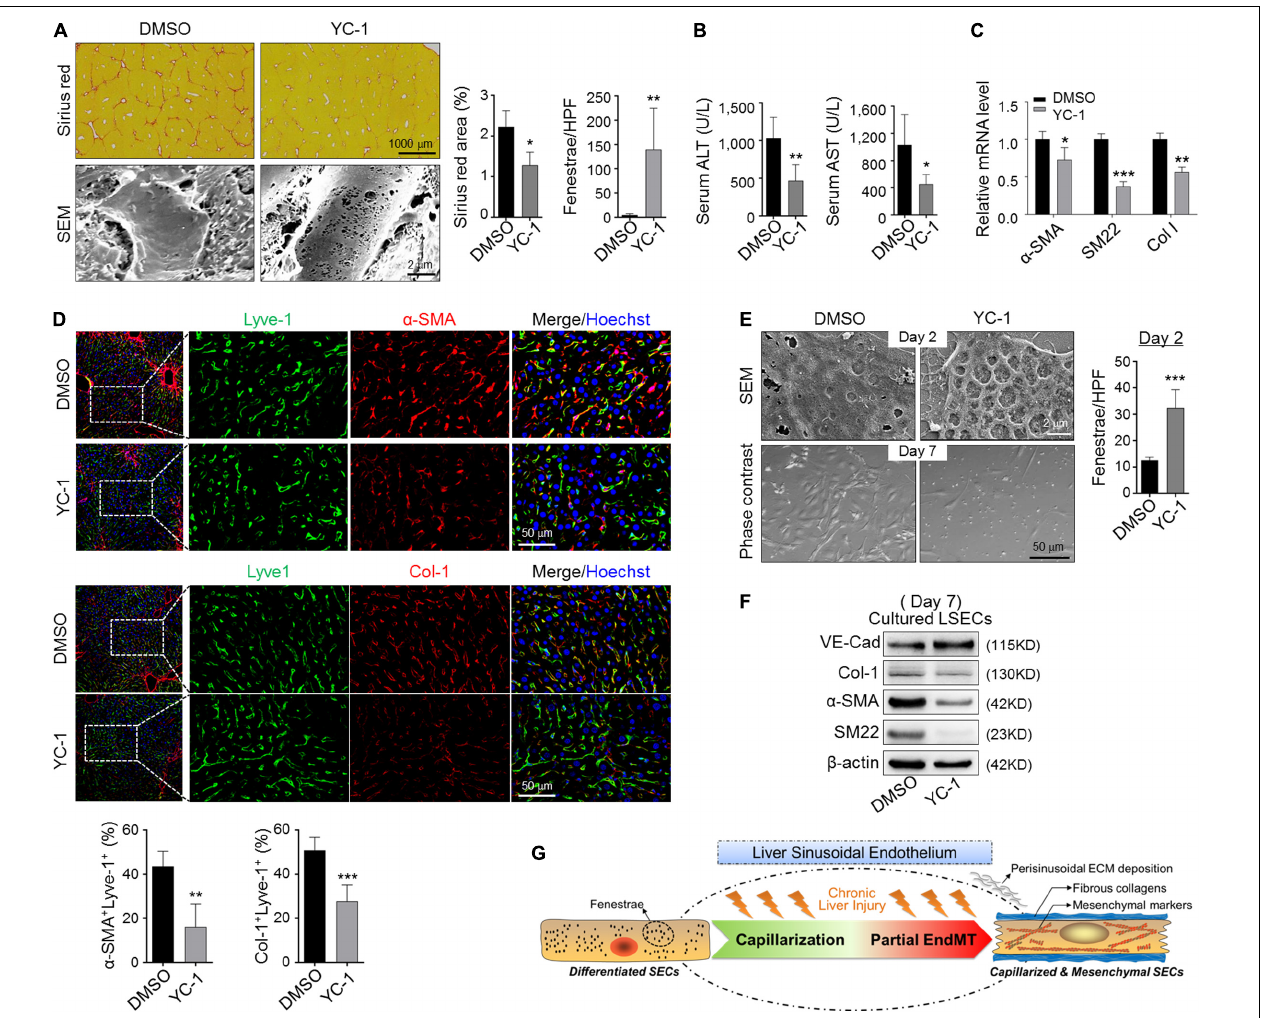
FIGURE 6 | Blocking capillarization simultaneously reverses the mesenchymal phenotypes of LSECs during liver fibrosis and in vitro culturing. (A,B) Mice bearing CCl 4 -fibrosis were treated with DMSO or YC-1. Liver sections were stained by Sirius red or observed under SEM. Sirius red + areas and fenestrae per high power field were quantitatively compared between the two groups (A, n = 6). Serum ALT and AST were determined (B, n = 6). (C) LSECs were isolated from mice in (A) and the expression of α -SMA, SM22, and Col-1 was evaluated by qRT-PCR ( n = 4). (D) Colocalization of Lyve1 and α -SMA/Col-1 in the sinusoidal areas is shown and quantitatively compared ( n = 4). (E,F) LSECs were cultured in the presence of DMSO or YC-1, and were observed under SEM and light microscope on days 2 and 7 of the culture, respectively. Fenestrae were quantified on day 2 and compared (E, n = 4). Expression of VE-cadherin and mesenchymal markers α -SMA, SM22, and Col-1 on day 7 was determined by Western blotting (F). Bars = means ± SD; * P < 0.05, ** P < 0.01, *** P < 0.001 vs. DMSO, using two-tailed t -test for (A–E). (G) Cartoon image shows that capillarized LSECs undergo partial endothelial-mesenchymal transition to actively deposit sinusoidal ECM in liver